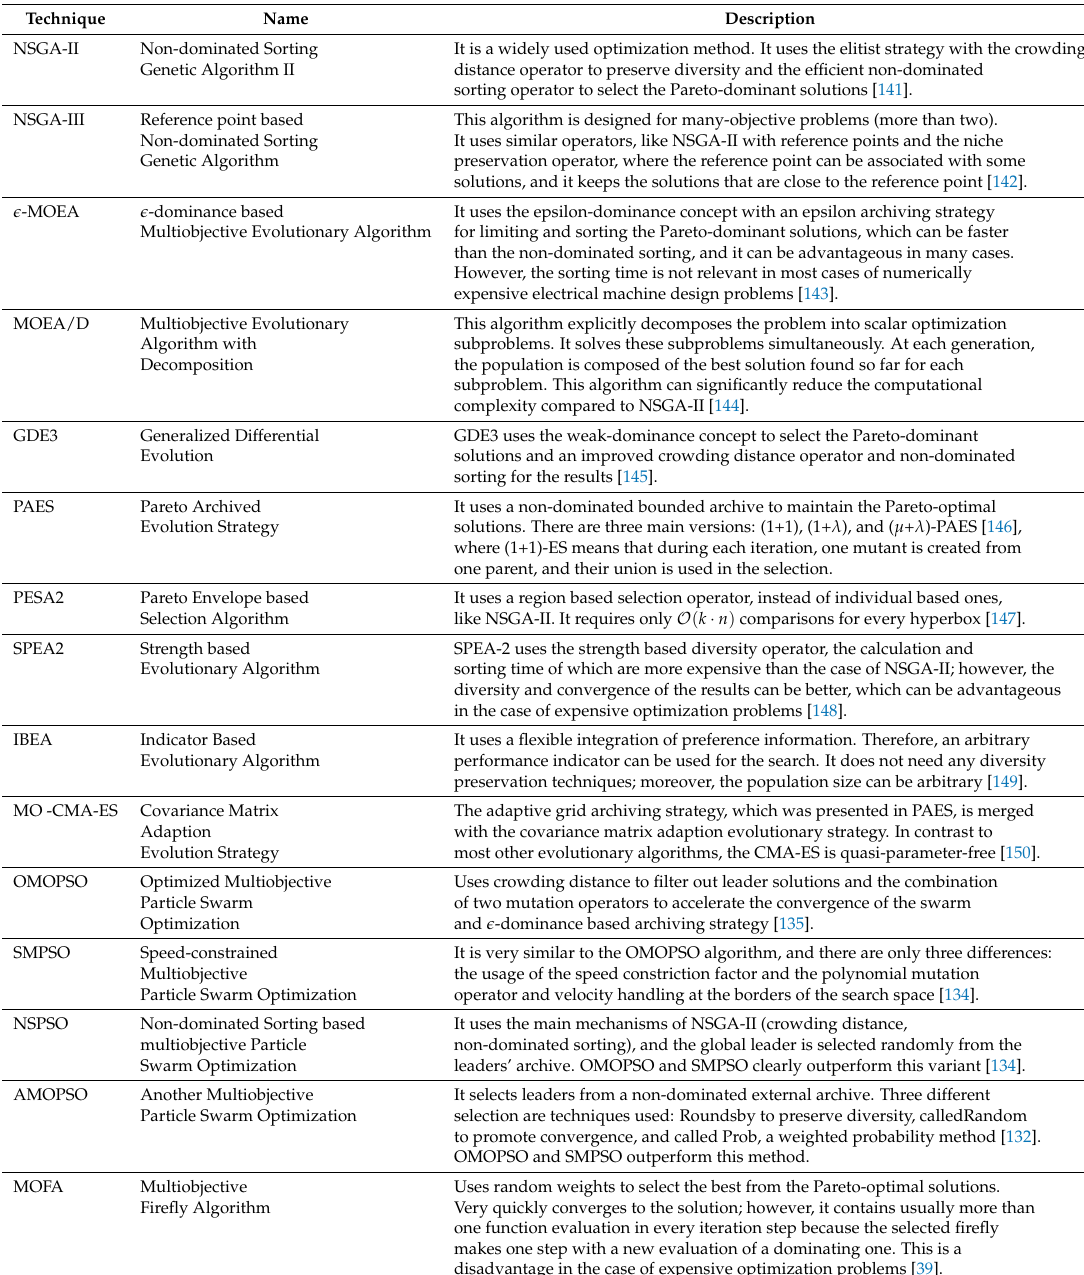
Table 1. Widely-used nature-inspired multiobjective optimization